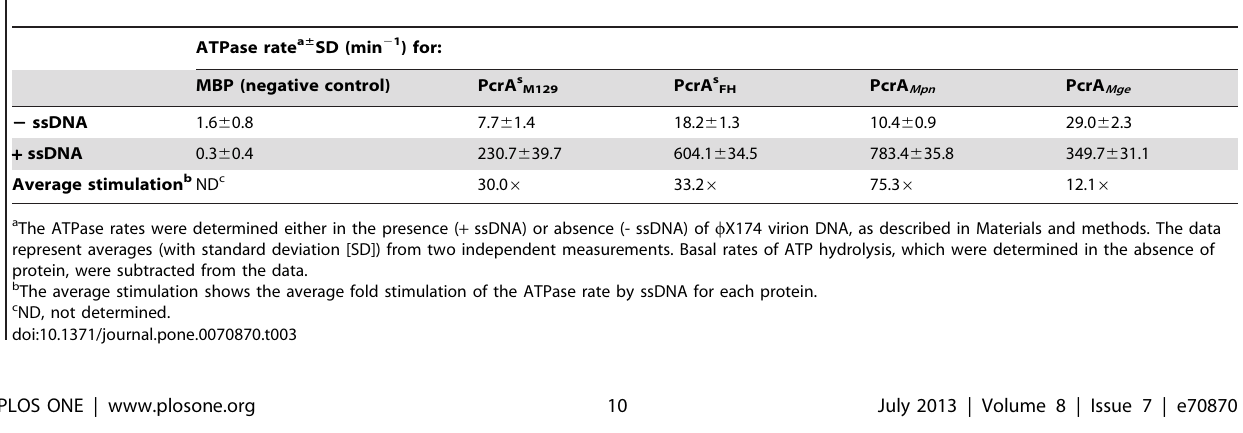
Table 3. ATPase rates of the PcrA helicases from M. pneumoniae and M. genitalium .